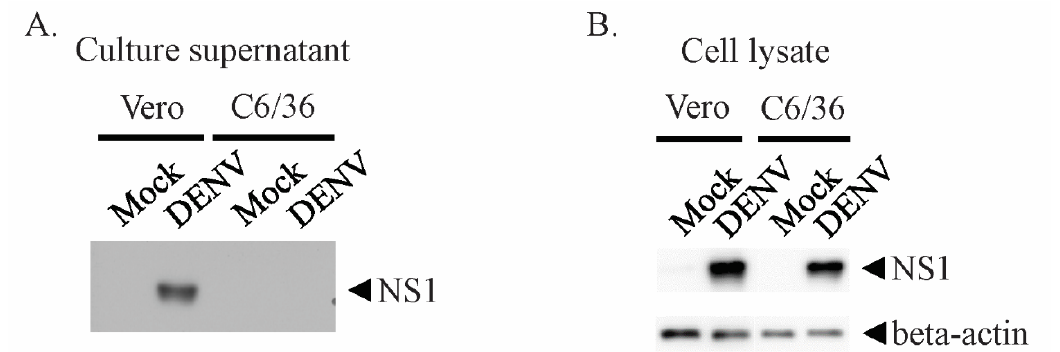
Figure 1. NS1 is secreted at undetectable levels in mosquito cell lines. Vero and C6/36 cells were infected with dengue virus (DENV) 2 at multiplicity of infection (MOI) = 0.5. After two days of incubation, culture supernatants and cells were harvested. The cells were lysed with 1% Triton X-100-phosphate-buffered saline (PBS) buffer. ( A ) Cell culture supernatant (20 μ L) and ( B ) cell lysate (10 μ g) were subjected to immunoblotting with non-structural protein 1 (NS1) antibody.